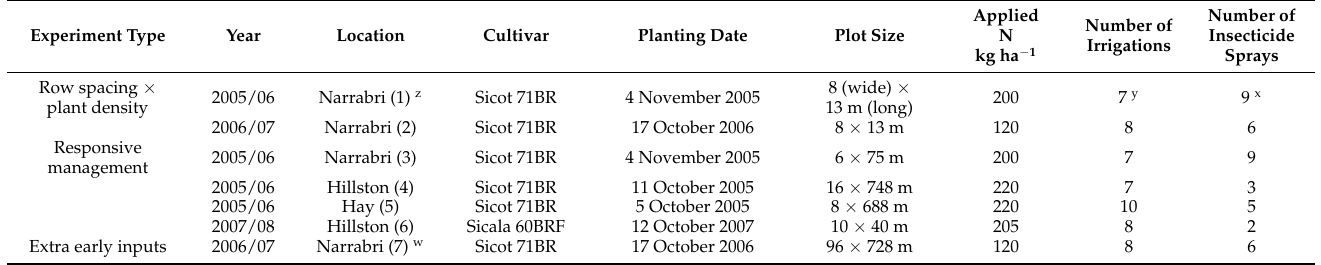
Table 1. Details of experiments investigating yield and maturity of ultra-narrow cotton